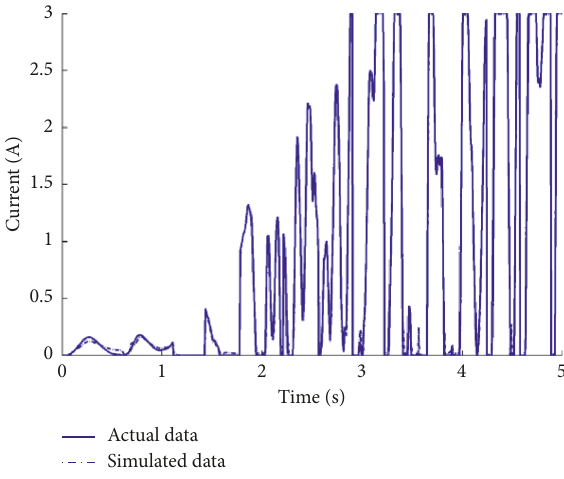
Figure 14: Comparison of simulation results and actual data of the inverse MR damper model.